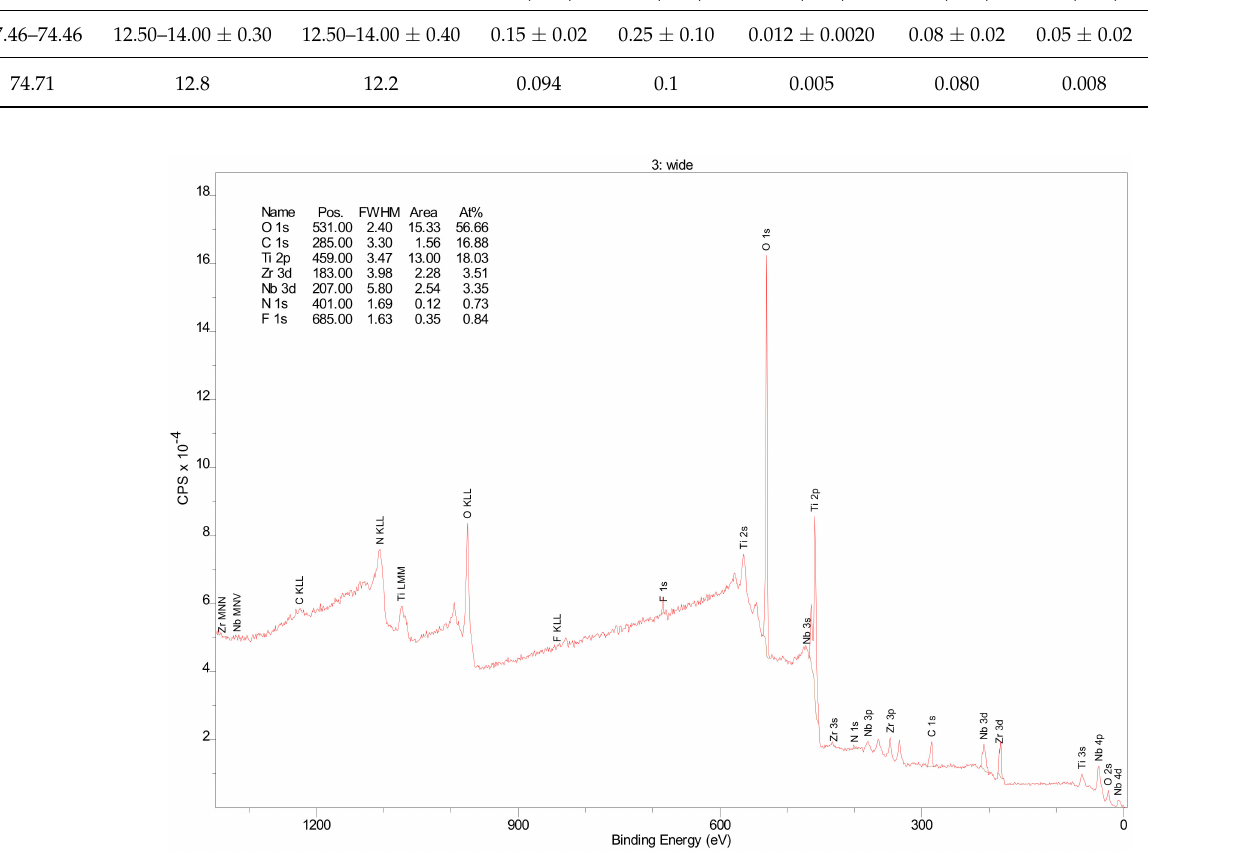
Figure 3. XPS widescan spectra of Ti-13Nb-13Zr titanium alloy sample after etching using Ar + 3 min, 3 kV, 20 µ A/cm 2 .